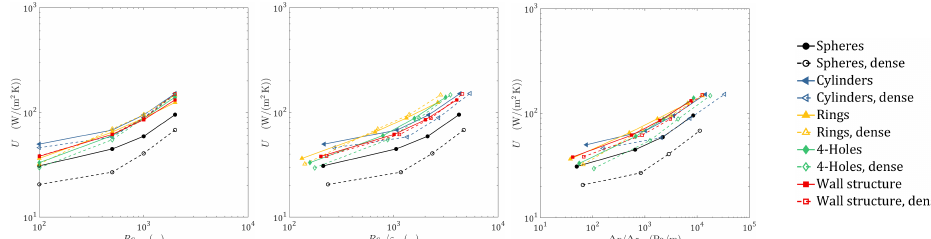
Figure 8. Global heat transfer coefficient as a function of Re p ( left ), Re p / ε ( middle ), and specific pressure drop ( right